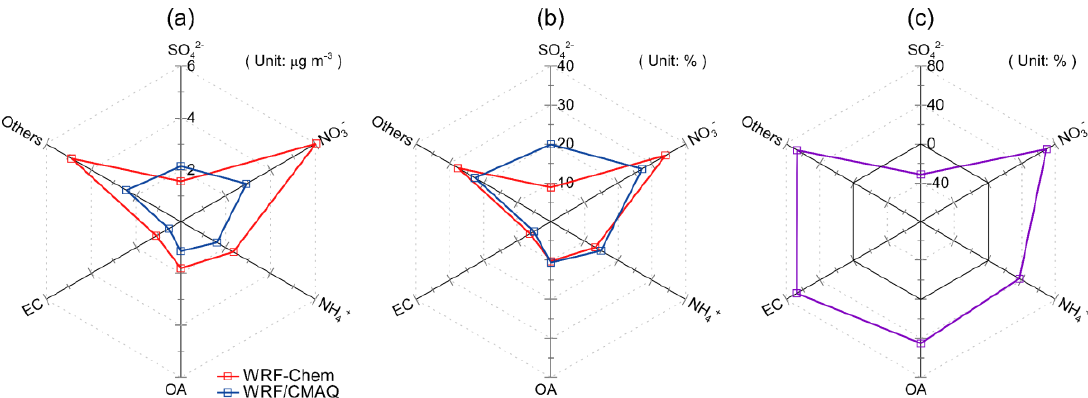
Figure 8. Comparison of domain mean atmospheric concentrations of the surface PM 2.5 chemical components simulated by the WRF-Chem and WRF/CMAQ models in ( a ) concentration, ( b ) mass fraction, and ( c ) fractional difference.